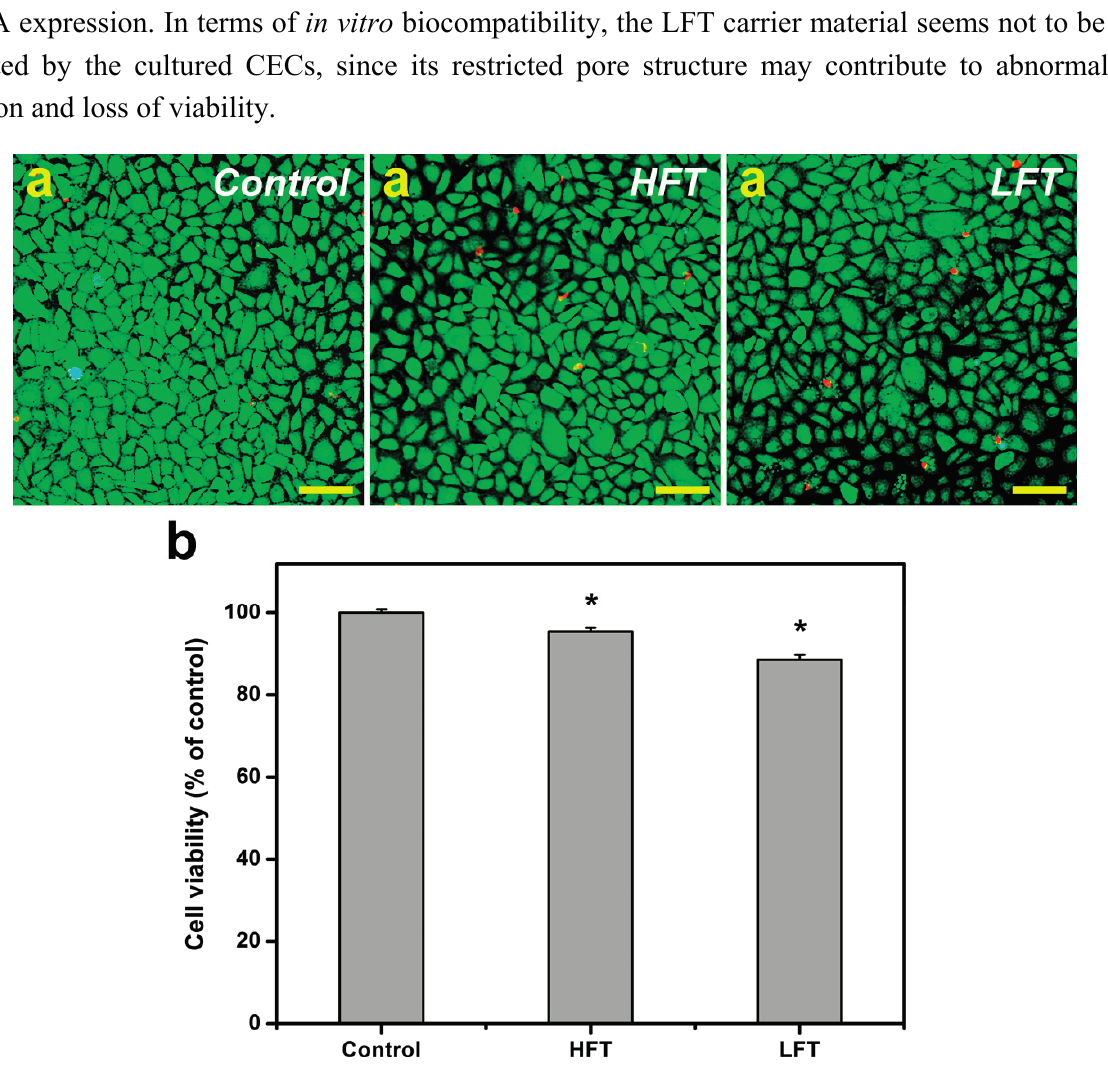
Figure 5. Cell viability of rabbit corneal endothelial cell (CEC) cultures was determined by staining with the Live/Dead Viability/Cytotoxicity Kit in which the live cells fluoresce green and dead cells fluoresce red. ( a ) Fluorescence images of cells in controls (without test materials) after 8 h of direct contact with different types of HA samples. Scale bars: 50 μ m; ( b ) Quantitative results are expressed as the percentage of control groups (viability of cells cultured in the absence of test materials). An asterisk indicates statistically-significant differences ( * p < 0.05; n = 3) as compared to the control